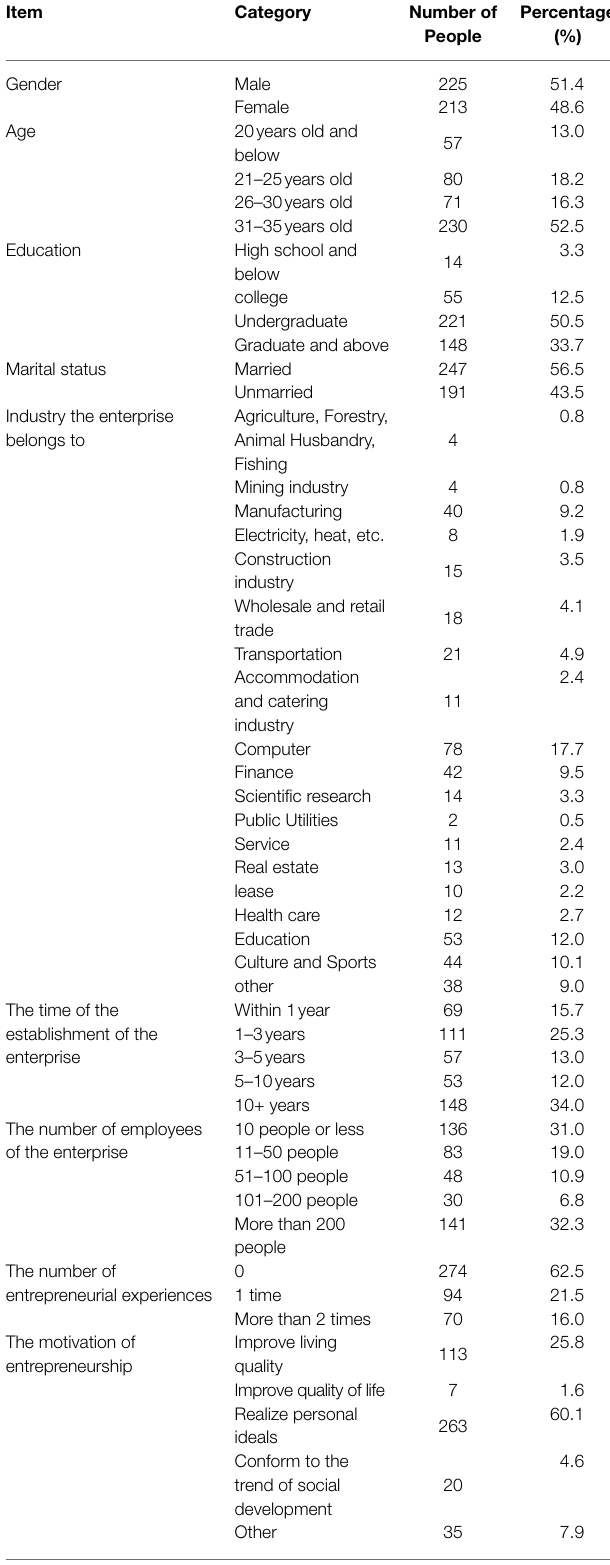
TABLE 1 | Descriptive statistical analysis of